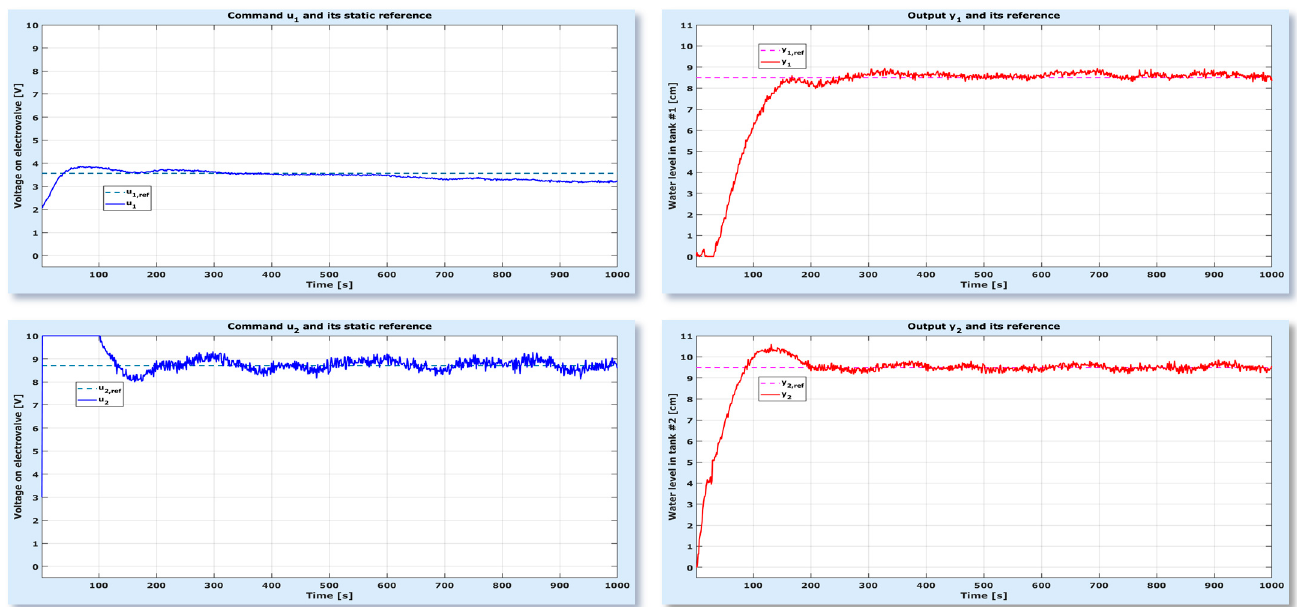
Electronics 2021 , 10 , x FOR PEER REVIEW 23 of 43 Figure 15. I/O signals for optimal PID-R controllers; in the case of <raw> idmo, IFA